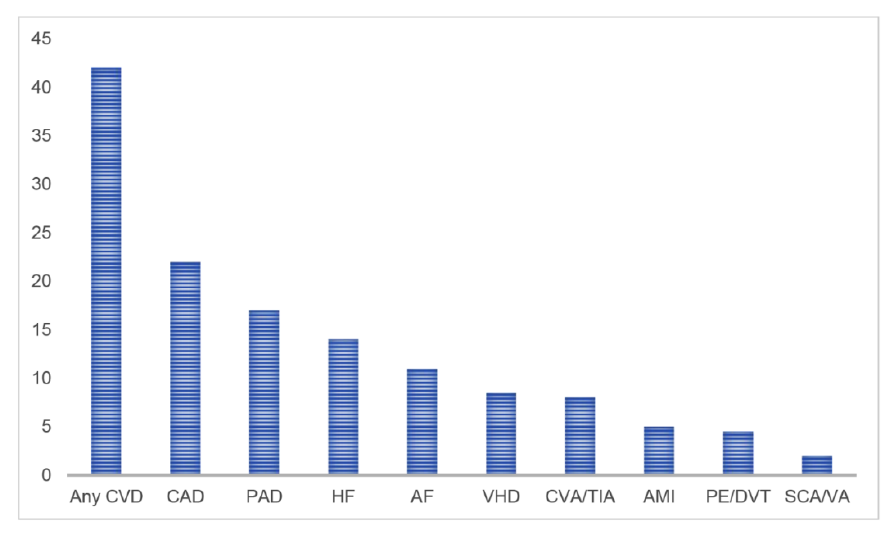
Figure 2. Incidence (%) of cardiovascular disease in kidney transplant recipients.